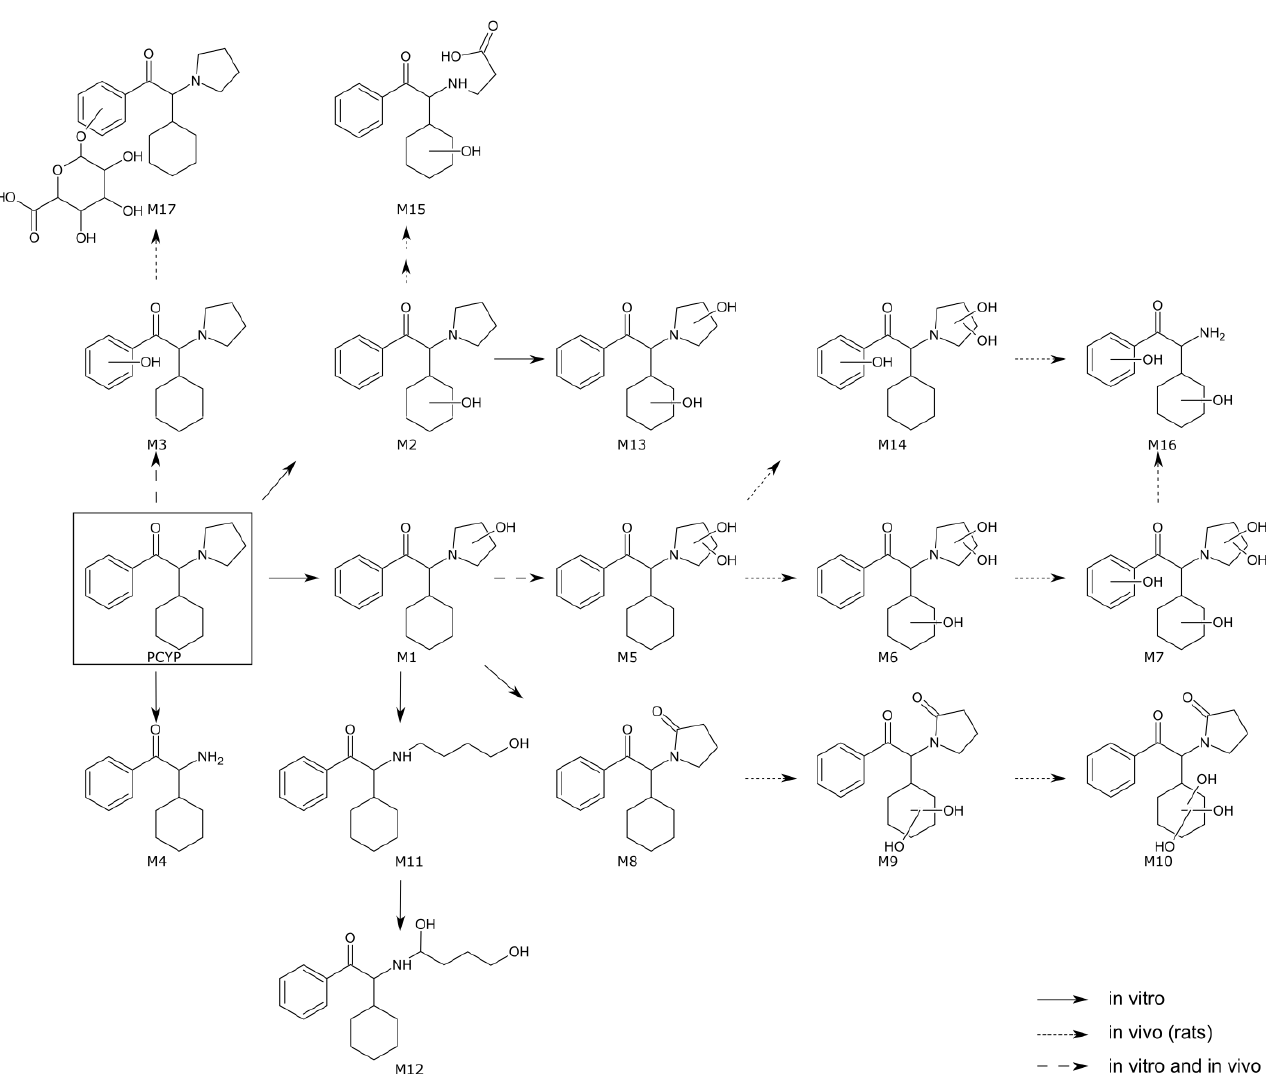
Figure 1. In vitro and in vivo metabolic pathways of PCYP. The parent compound is indicated by a black square, undefined hydroxylation positions are indicated by unspecific bonds. Metabolite identification numbers (M) match with the metabolites listed in Table S5.